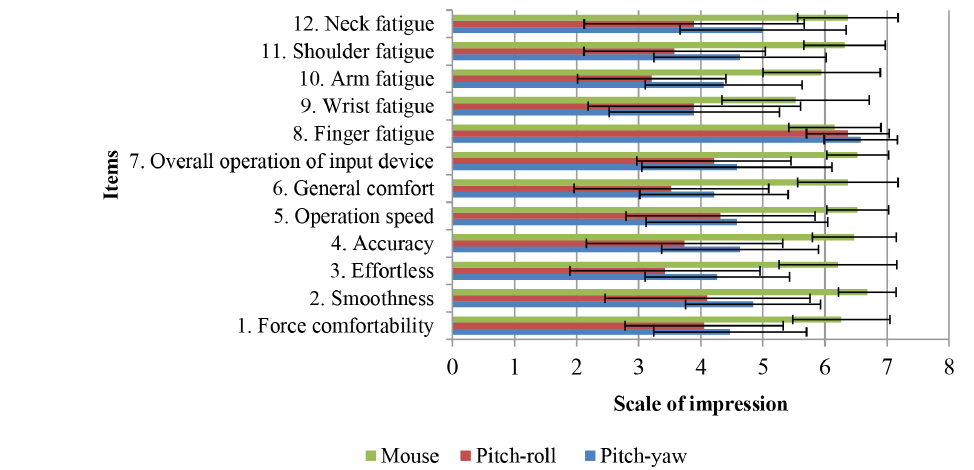
Figure 7. Results of the pointing questionnaire, where option 7 on the Likert scale is the best impression.